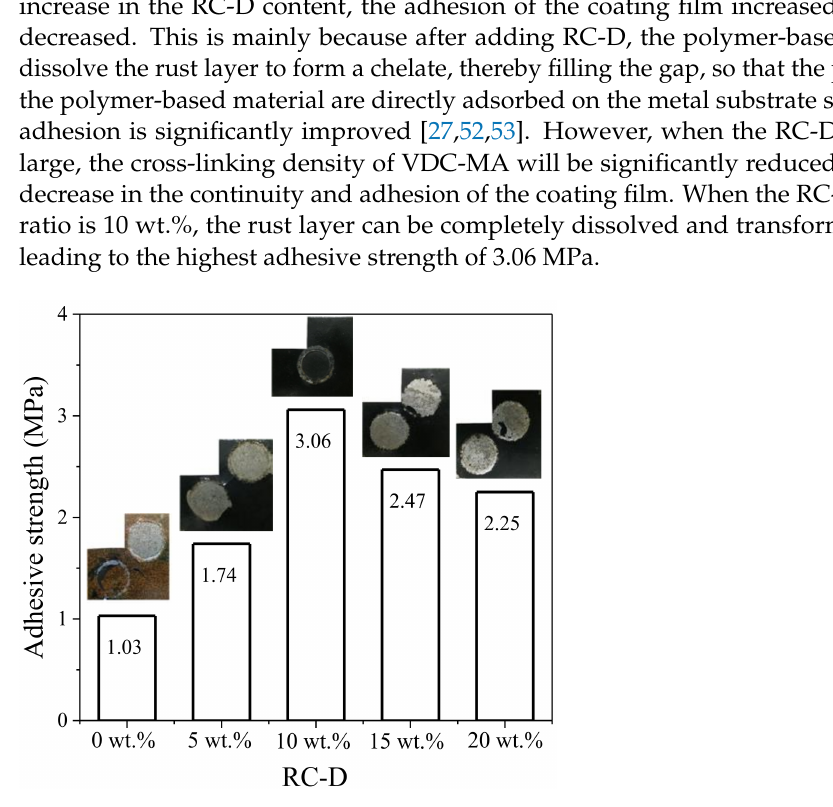
Figure 10. The adhesive strength between each polymer-based paint film and the rusty carbon steel sheets and the failure types in the surface peeling